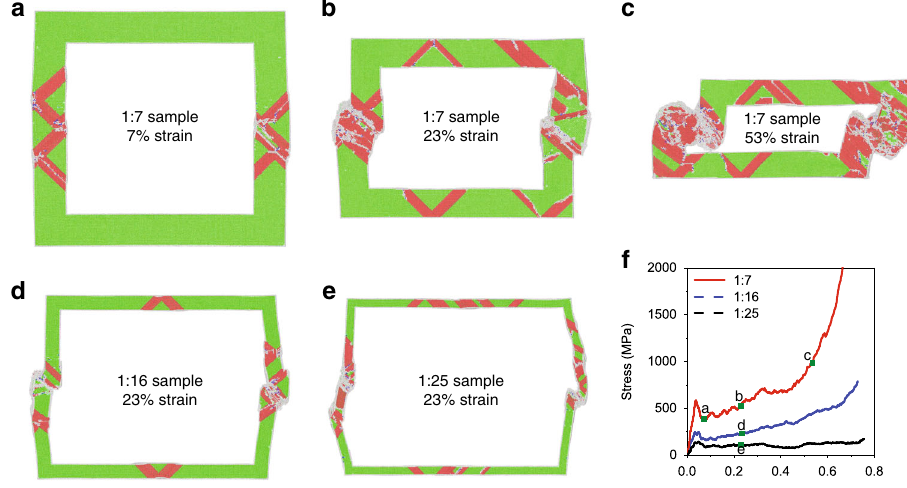
Fig. 6 MD simulations of Ag nanobox. Cross-sectional view of 1:7 sample (ratio of wall thickness to length) at a 7% strain, b 23% strain, and c 53% strain. Cross-sectional view of d 1:16 sample and e 1:25 sample at 23% strain. Green atoms are in fcc positions, red atoms are at stacking faults, and gray atoms are non-lattice atoms (either surface atoms or atoms with highly deformed local environment). f Compressive stress-strain curves for simulated samples of different geometries. The locations that correspond to the MD snapshots in a – e are marked in the stress-strain